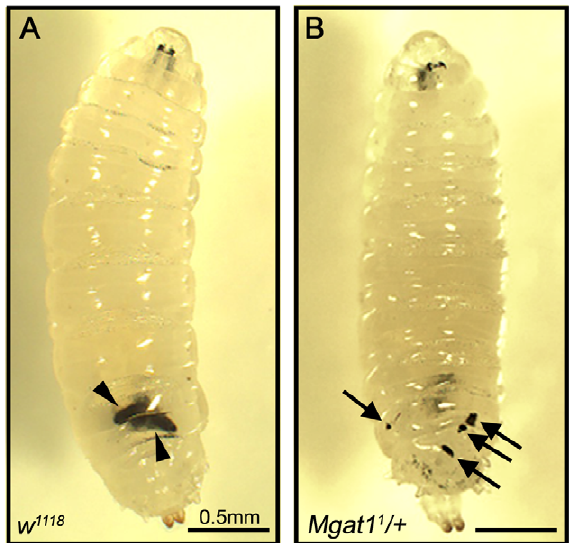
Figure 5. Mgat1 mutants have a ‘broken capsule’ phenotype. L. clavipes attacked larvae imaged 48–72 hours PA. (A) w 1118 larvae successfully encapsulated L. clavipes eggs, indicated by arrowheads. (B) Mgat1 1 / + larvae had small pieces of melanized tissue floating within the hemocoel, indicated by arrows. Scale bars indicate 0.5 mm.